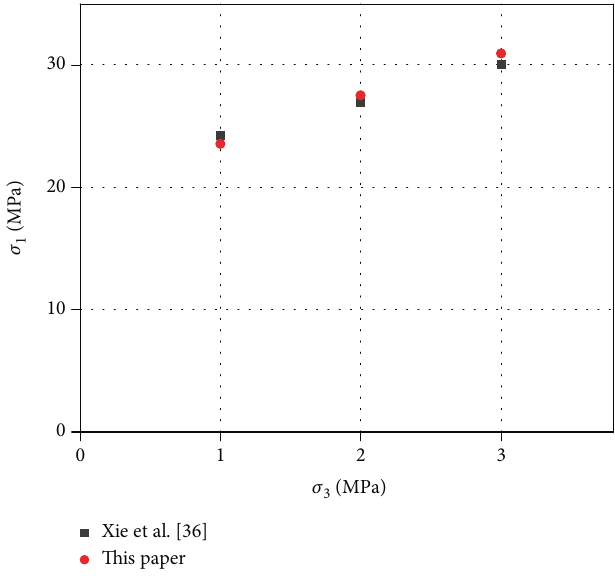
Figure 10: Comparison of biaxial compression test of